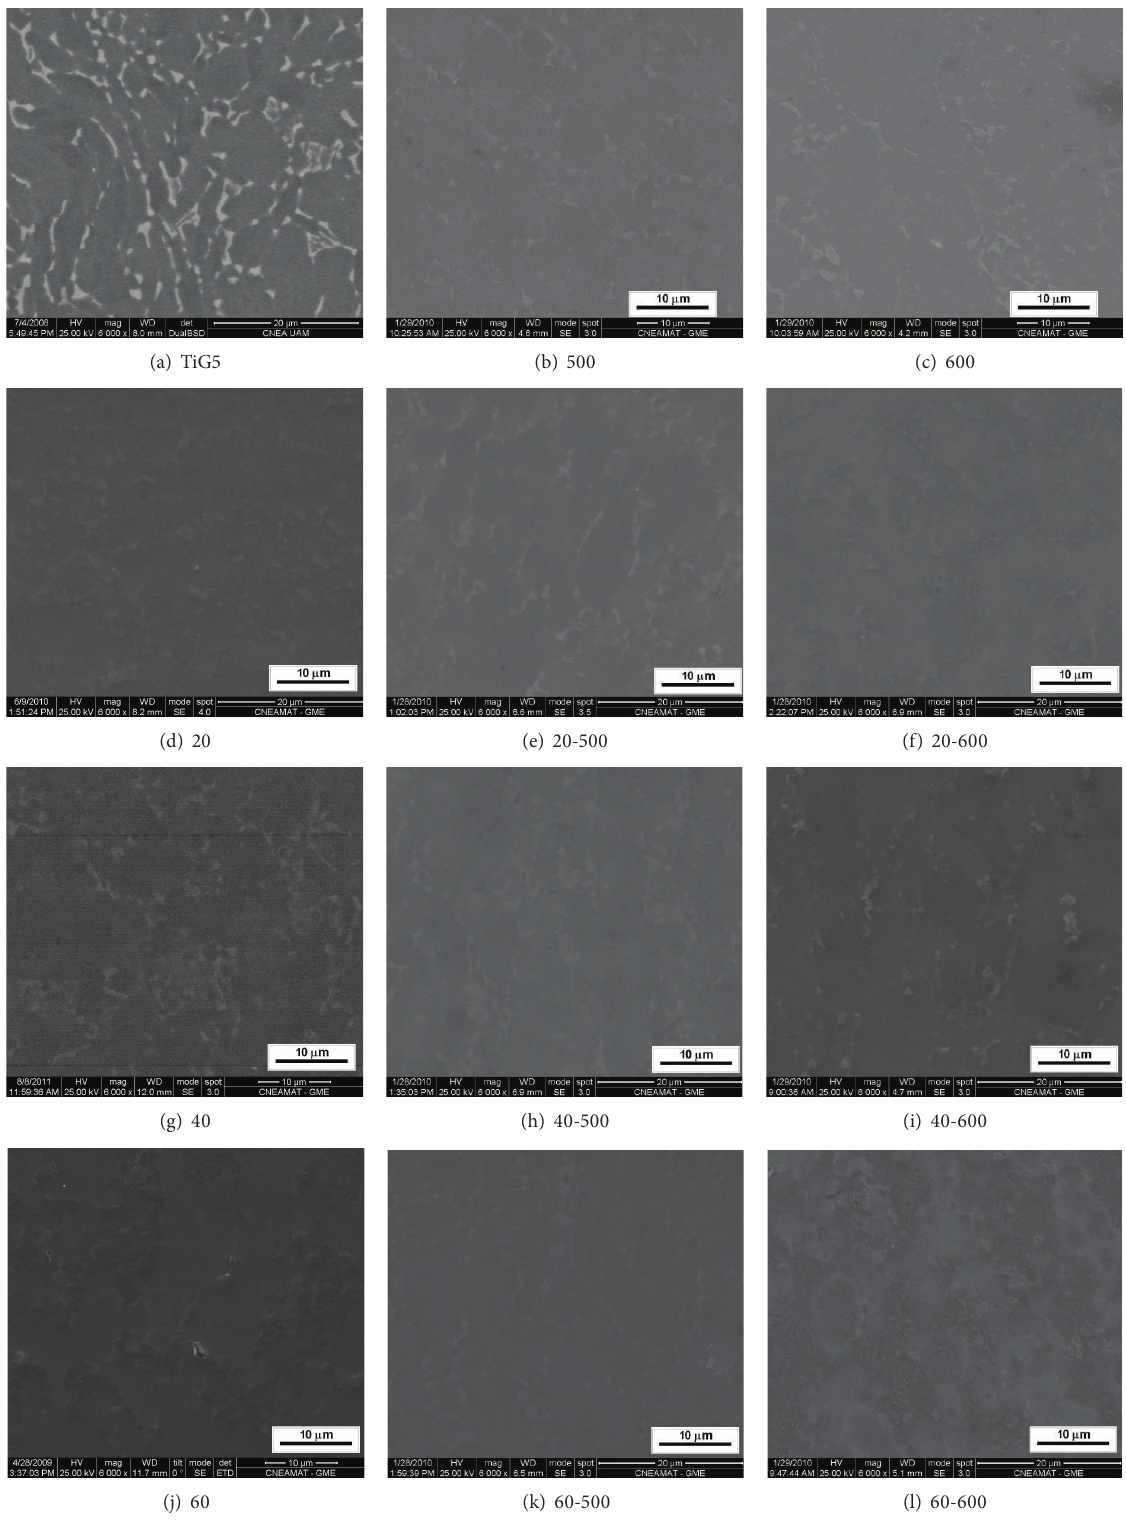
Figure 3: SEM micrographs of